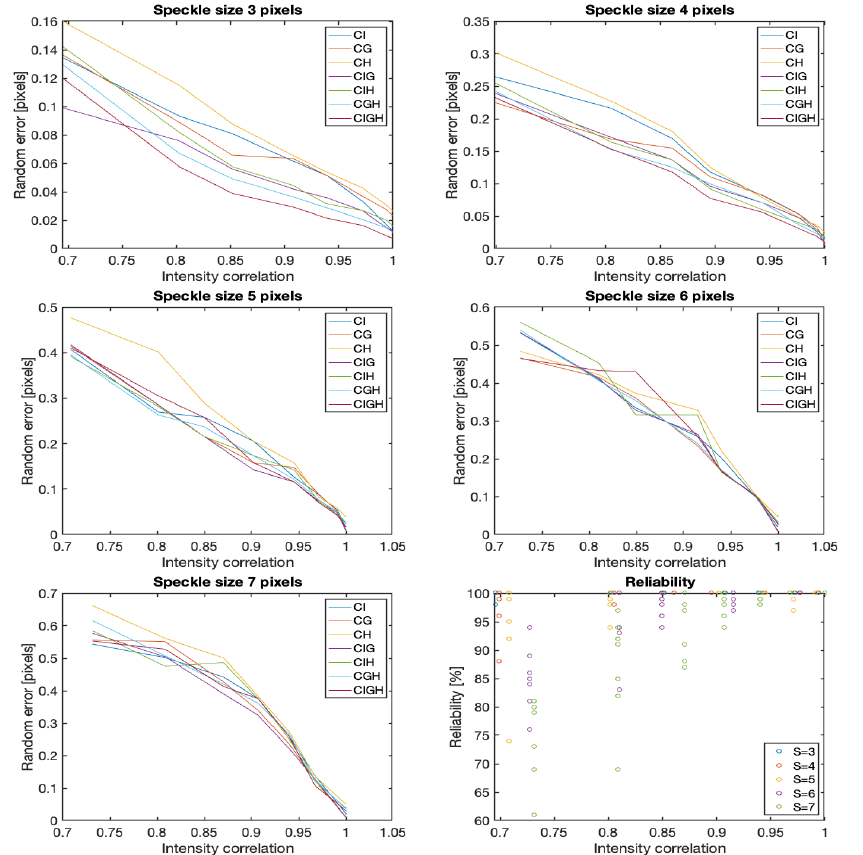
Figure 3. Results from the simulation. The plots show, row-wise, random errors from the different types of correlation functions defined by Equations (1) and (3)–(8) as a function of intensity correlation value for speckle sizes S = 3, 4, 5, 6, and 7 pixels, respectively. The lower right plot shows the reliability of the evaluations as a function of intensity